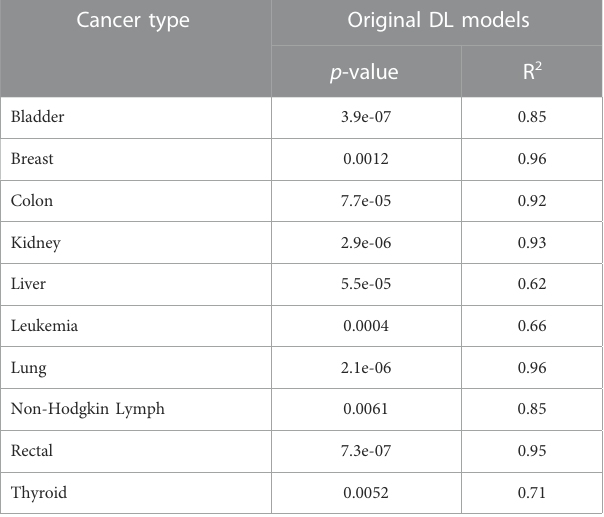
TABLE 5 The p -values and R 2 evaluation metrics for all cancer types that demonstrate the DL models prediction performance is statistical signi fi cance. Cancer